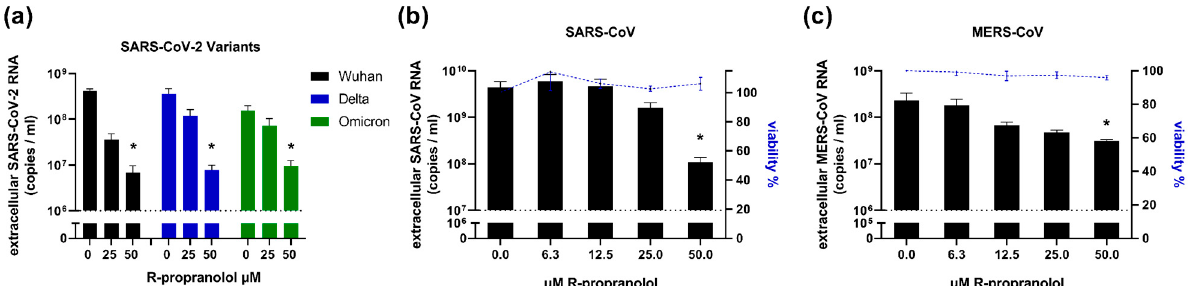
Figure 6. Effect of R-propranolol on replication of SARS-CoV-2 variants, SARS-CoV, and MERS-CoV. ( a ) Viral load reduction assay on Vero E6 cells with SARS-CoV-2 variants. The viral load at 16